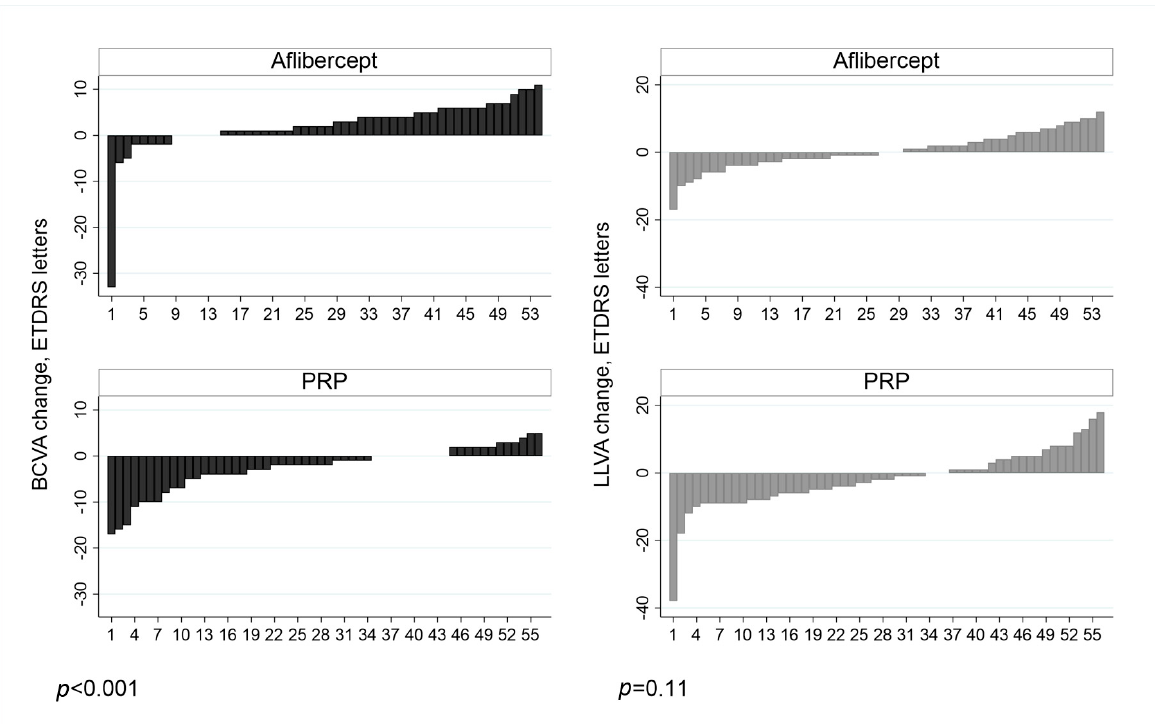
Figure 3. Shows the participants’ level of change in best corrected visual acuity (BCVA) and low luminance visual (LLVA) in treatment naïve patients at 52 weeks.